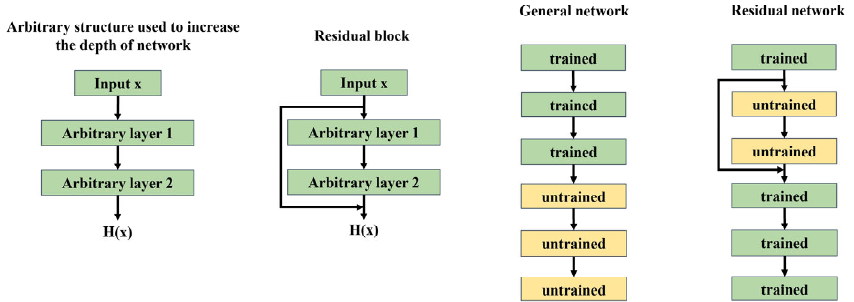
Figure 3. Comparison between residual and ordinary network.